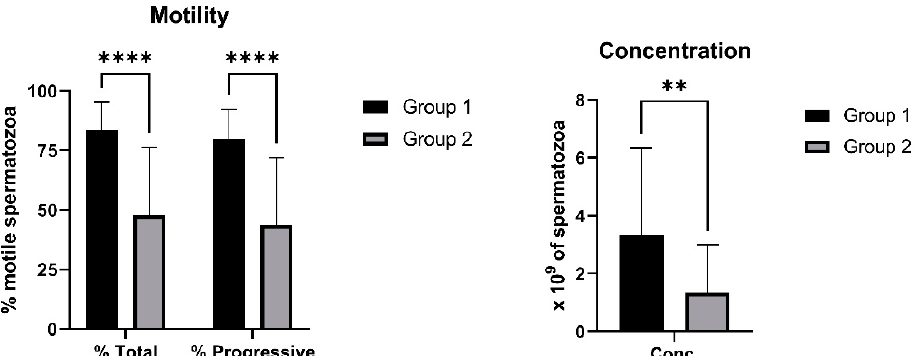
Figure 2. CASA parameters of analyzed ram semen sample according to the sperm viability. Group 1—semen samples with sperm viability over 60%, Group 2—semen samples with sperm viability under 60%, % Total—percentage of totally motile spermatozoa, % Progressive—percentage of pro- gressively motile spermatozoa, Conc.—concentration of spermatozoa. The data are expressed as the means ± SD; difference is statistically significant at ** p < 0.01 and **** p < 0.0001.